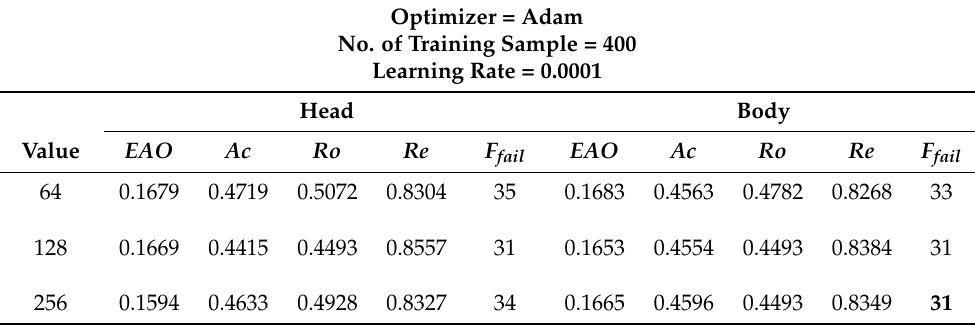
Table 7. Performance evaluations of the mini-batch size